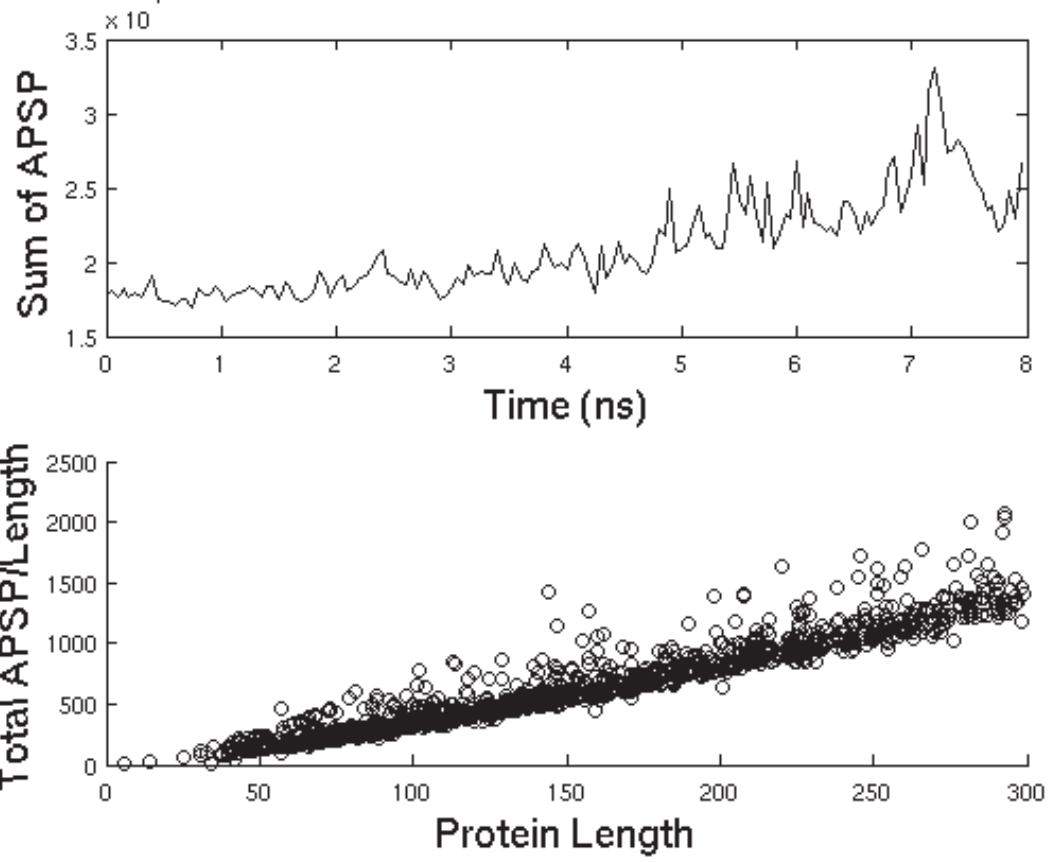
Figure 12. APSP over unfolding. Top panel: Plot of APSP versus the unfolding time. The APSP increases from its value at the native structure almost monotonically during unfolding. Bottom panel: Plot of APSP/Length versus protein length for 1320 single-chain proteins. The linear scaling obtained here is similar to the scaling of mean FPT/Length versus the source-target distance suggesting that there exists an optimal range of APSP values for a given protein